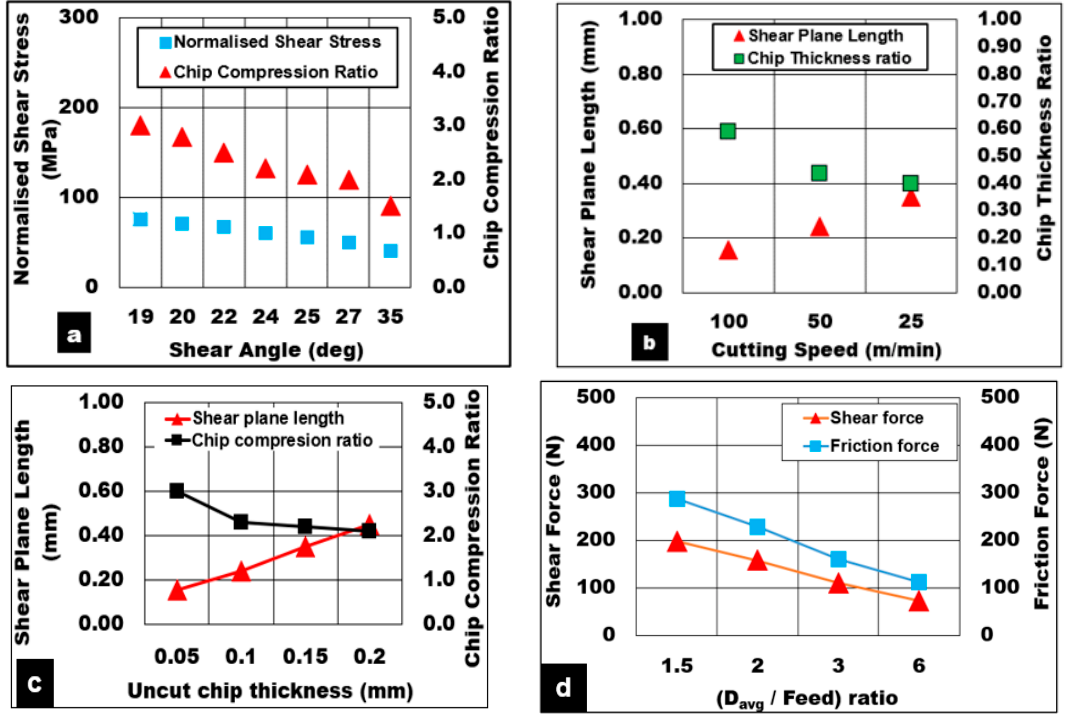
Figure 3. Relationship between various cutting parameters. ( a ) Effect of increasing shear angle on shear stress and chip compression ratio, ( b ) Effect of cutting speed on shear plane length and chip compression ratio, (feed = 0.1 mm). ( c ) Effect of uncut chip thickness on shear plane length and chip compression ratio (Vc = 50 m/min), ( d ) Correlation between (microballoon diameter to feed ratio) with machining forces. (Bubble volume fraction = 15%, b = 3 mm, Dry cut).